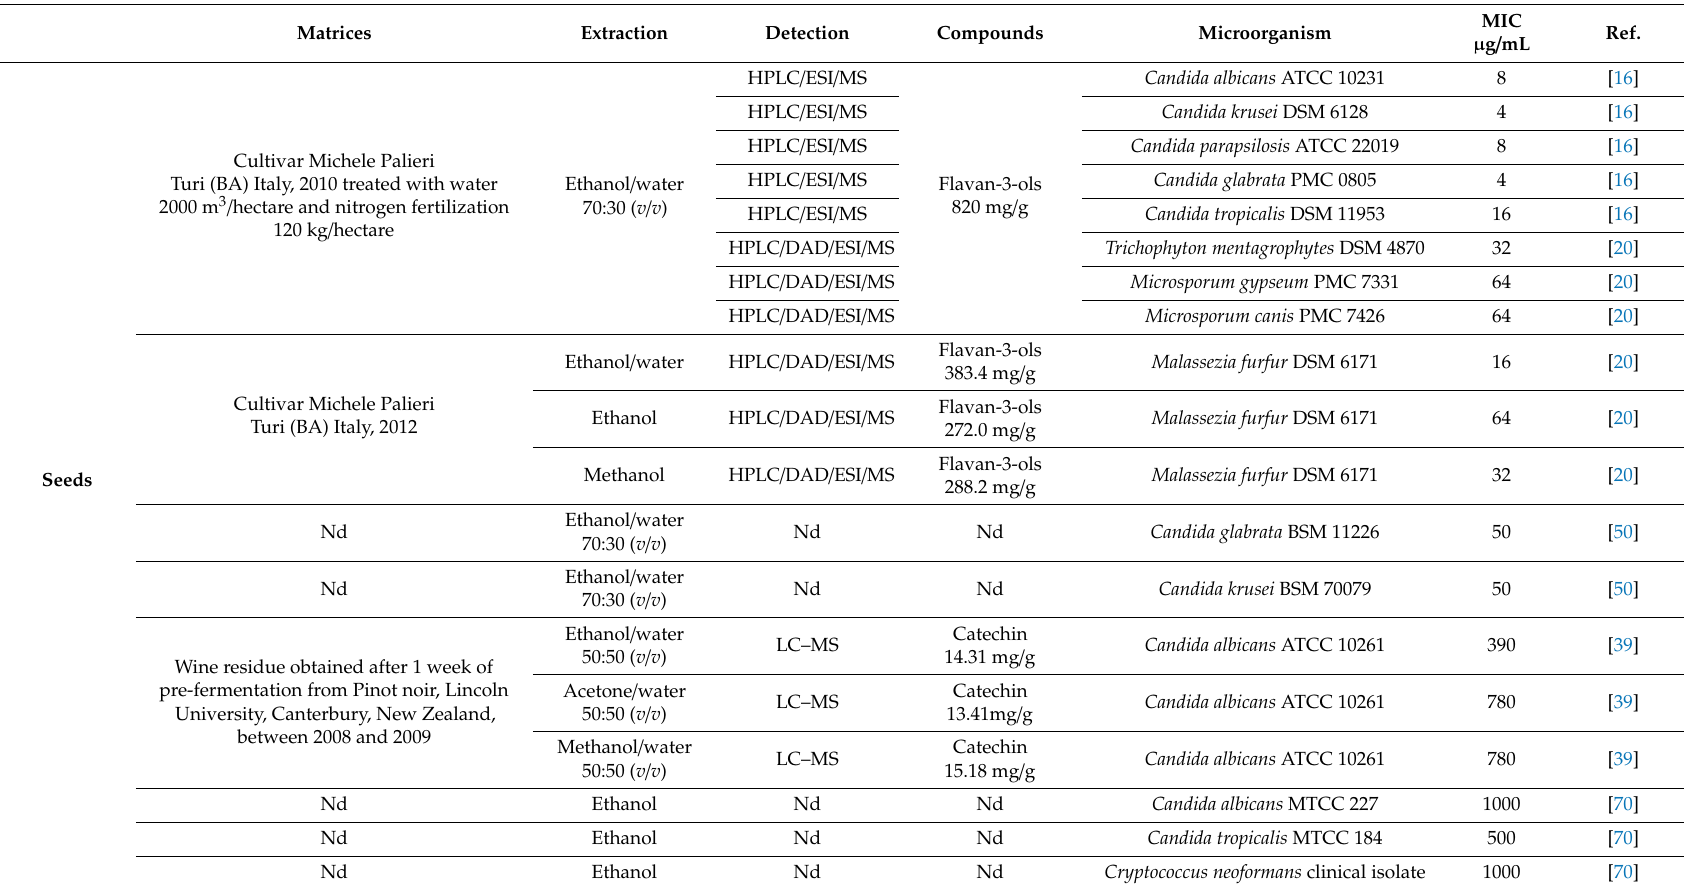
Table 2. Antifungal activities of crude extracts, phenolic and polyphenolic compounds obtained from di ff erent matrices of V. vinifera against human fungal